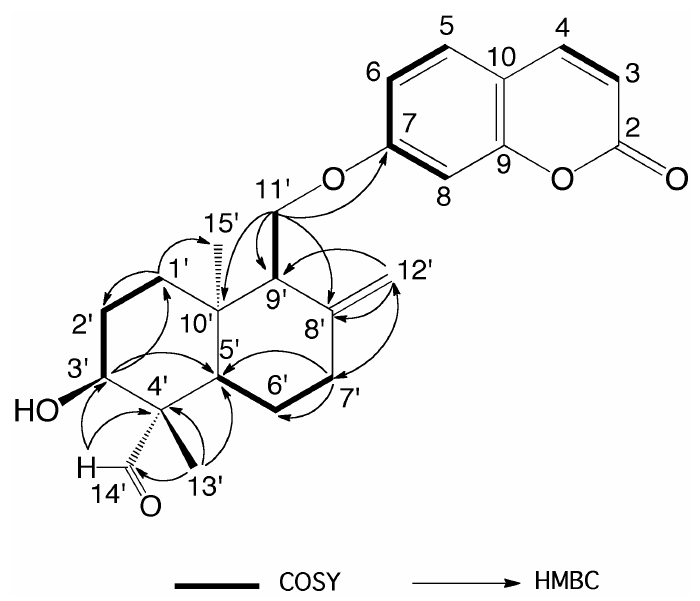
Figure 2. Key COSY and HMBC correlations of anatolicin ( 8 ).